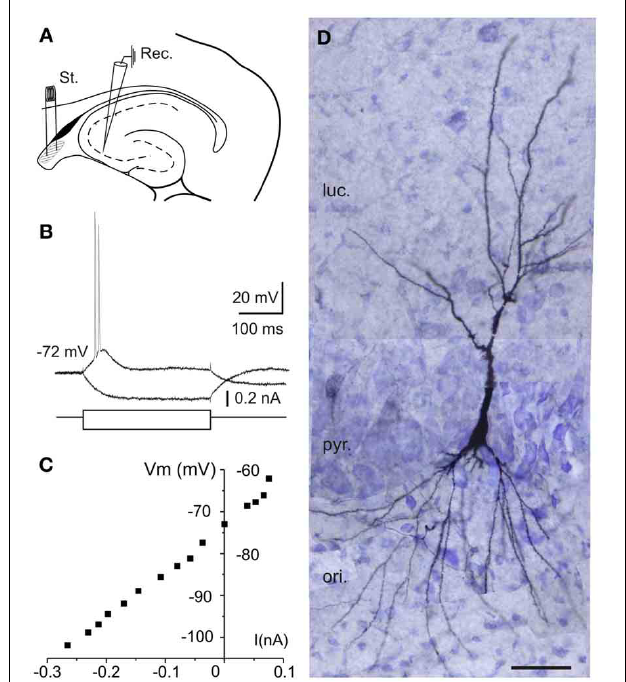
FIGURE 1 | Location and electrophysiological characterization of the recorded neurons in hippocampal slices. (A) Experimental design. Diagram of stimulation and recording sites in an hippocampal horizontal section. Schematic location of recording (Rec.) and stimulating (St.) electrodes is shown. Stimuli were applied to the lateral part of the fimbria (shaded area). (B) Response of a CA3 neuron to depolarizing pulses consisted of two to five spikes with marked spike frequency adaptation with a depolarizing current pulse (100pA, 300ms) while hyperpolarizing current pulse injection ( − 160pA, 300ms) induced a hyperpolarizing response that allowed us monitoring the input resistance during the experiments. (C) Current-voltage ( I - V ) relationships for the pyramidal neuron recorded in (B) . (D) Reconstruction of the CA3 neuron recorded in (B,C) labeled with biocytin after intracellular recording from 40- μ m-thick serial sections. Note the pyramidal morphology of the injected hippocampal cell. ori, stratum oriens ; pyr, stratum pyramidale ; luc, stratum lucidum ; Scale bar 50 μ